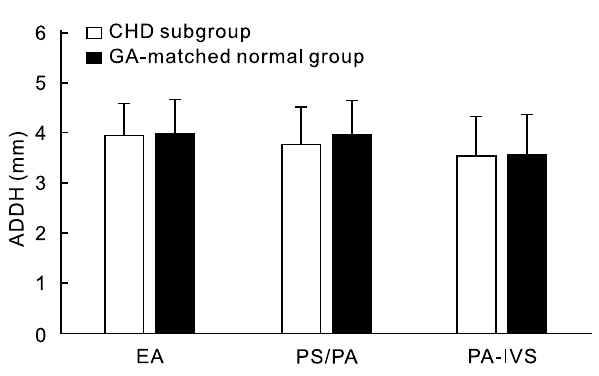
Figure 4 ADDH differences between conotruncal defects and GA- matched normal subgroups. ADDH, aortic diameter at the diaphragmatic; CHD, congenital heart disease; GA, gestation age; TOF, tetralogy of Fallot; DORV, double outlet of right ventricle; TGA, transposition of great arteries; TA, truncus